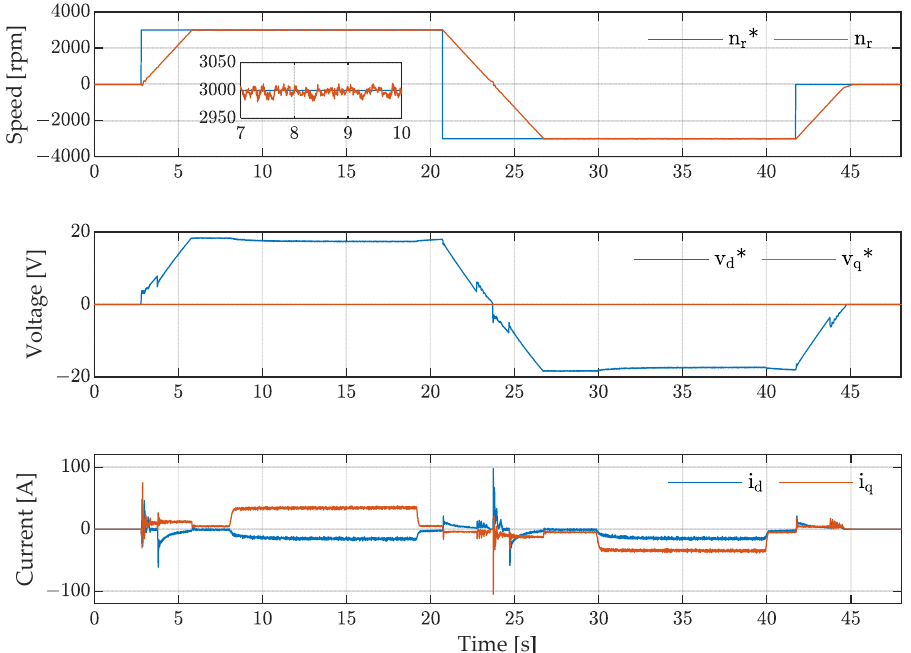
Figure 21. Ramp ‐ up and ramp ‐ down with the nominal reference speed and 50% load applied at Figure 21. Ramp-up and ramp-down with the nominal reference speed and 50% load applied at steady ‐ state, with a required power factor of 1: speed, dq voltages, dq currents. steady-state, with a required power factor of 1: speed, dq voltages, dq